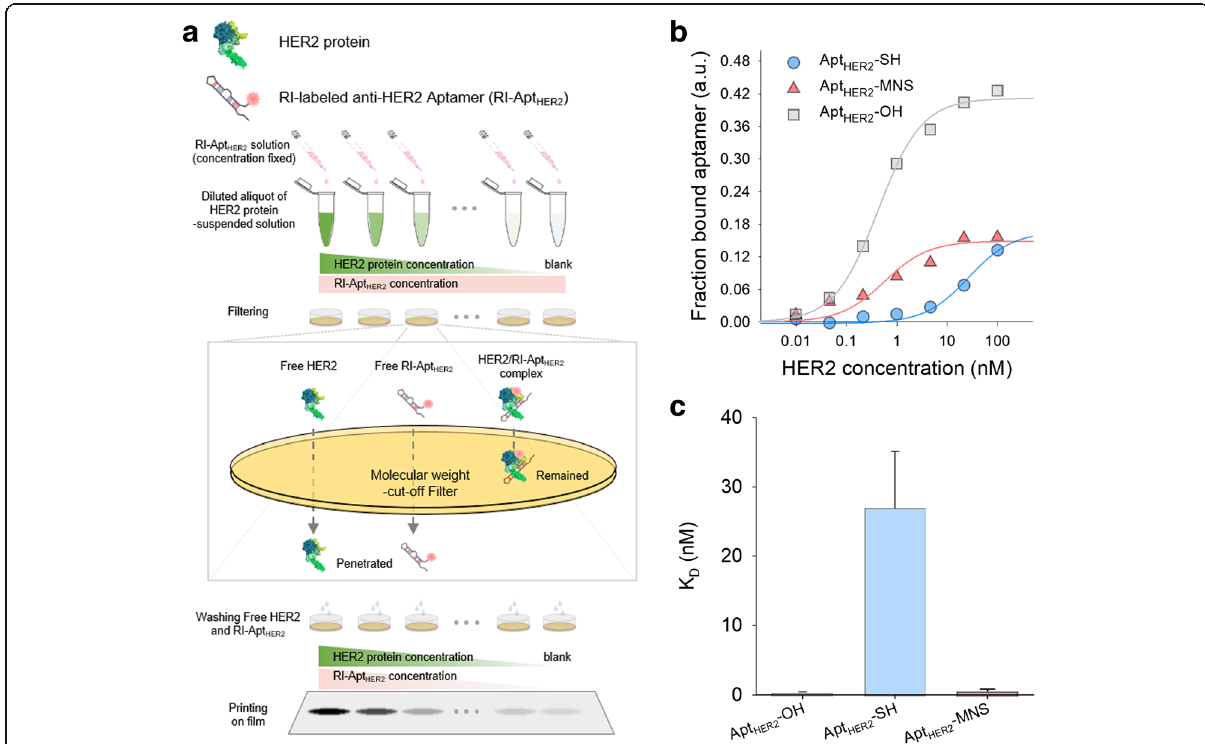
Fig. 4 Binding affinity data of anti-HER2 aptamer (Apt HER2 -OH) thiolated anti-HER2 aptamer (Apt HER2 -SH) and Apt HER2 -MNS onto HER2 proteins by measuring the filter binding assay. a The schematic illustration showing the process of filter binding assay of aptamers. b The fraction bound aptamer graph against HER2 concentration. c The K d value graph of Apt HER2 -OH (0.42±0.05 nM, R 2 =0.99, p <0.0001), Apt HER2 -SH (26.88±8.24 nM, R 2 =0.98, p <0.0001), and Apt HER2 -MNS (0.57±0.26 nM, R 2 =0.91, p =0.001) calculated from b . Error bars were represented by positive y -axis